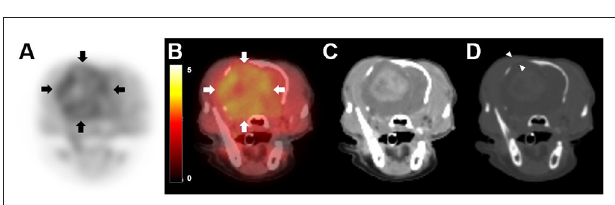
FIGURE 2 | 18F-fluorodopa (18F-FDOPA) positron emission tomography (PET)/computed tomography (CT) findings in a dog with meningioma. PET/CT scan was performed 119 days after initial chemotherapy. (A) On 18F-FDOPA PET image, increased 18F-FDOPA uptake is shown with a black color, while low uptake is shown with a white color. 18F-FDOPA uptake was remarkable in the lesion (arrows). (B) On PET/CT fusion image, increased 18F-FDOPA uptake appeared to be yellow, while low uptake appeared black to red. (C) A contrast-enhanced CT image shows an intense enhancement of the mass. (D) Bone window CT after contrast medium injection (window width of 2,000 Hounsfield units, window level of 500 Hounsfield units) revealed cranial bone lysis around the tumor